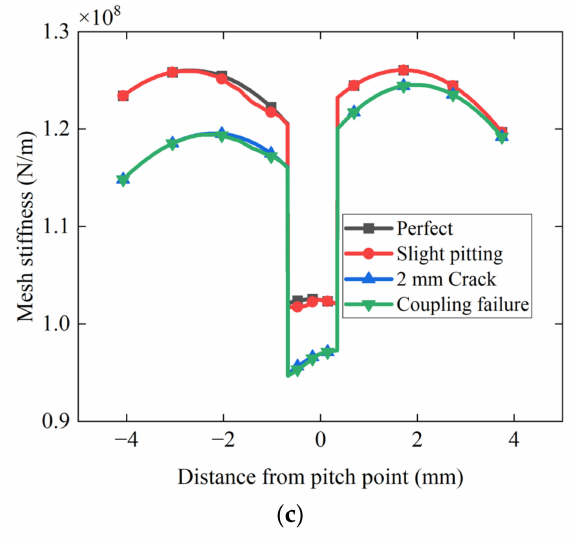
Figure 11. The crack effect on meshing stiffness with slight pitting: ( a ) At the stage of 1 mm crack; ( b ) At the stage of 1.5 mm crack; ( c ) At the stage of 2 mm crack. The number of pits at the severe pitting stage is twice that of the moderate pitting stage, and the pitting craters have spread over almost the entire tooth surface, as shown in Figure 6d. Due to the further expansion of the failed area caused by pitting, the stiffness reduction in the double-tooth and single-tooth areas is extremely significant compared to slight and moderate pitting, as shown in Figure 13. The effect of pitting on stiffness exceeds the effect of cracking at all stages. The coupling stiffness is close to the pitting stiffness.